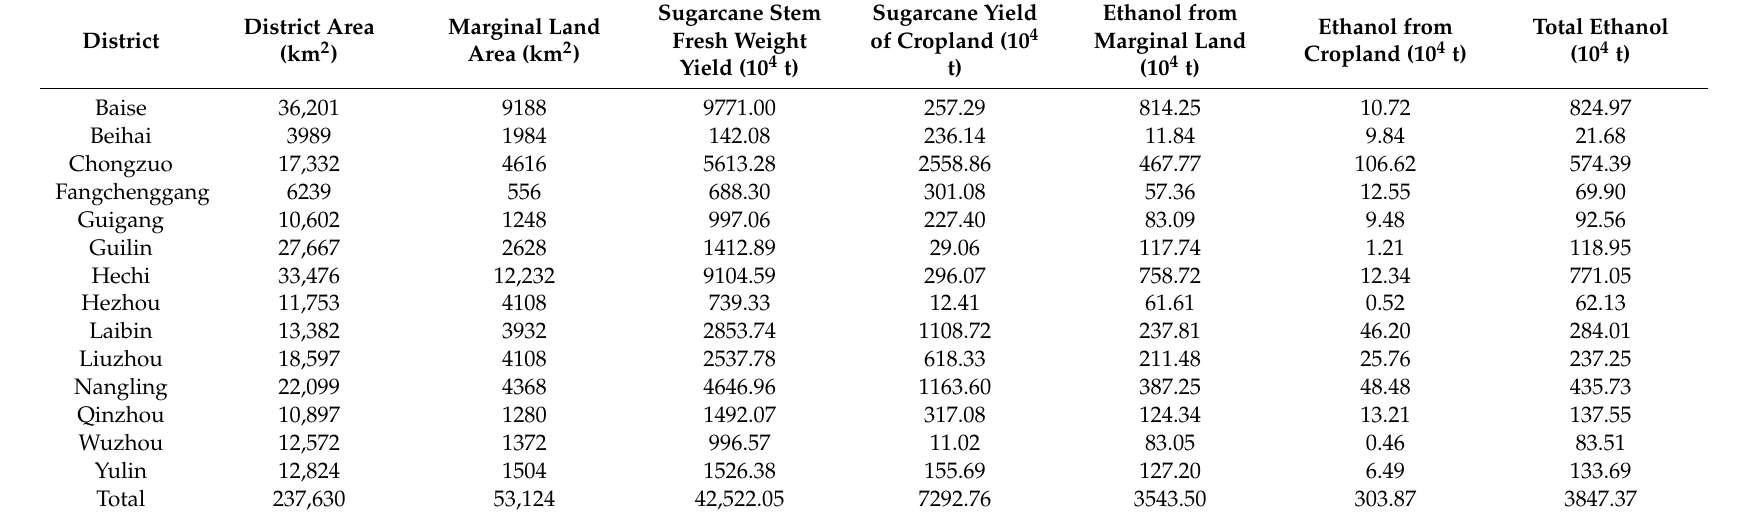
Table 11. Statistics of sugarcane-based ethanol energy potential in cities of Guangxi Zhuang Autonomous